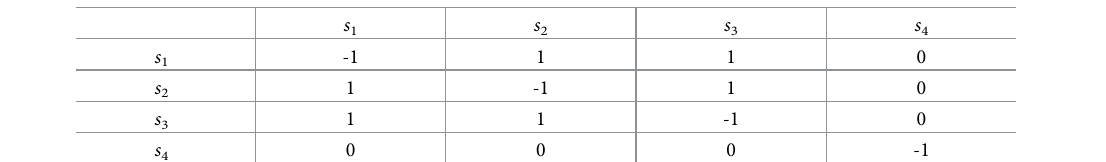
Table 1. Matrix A for the set of posets P